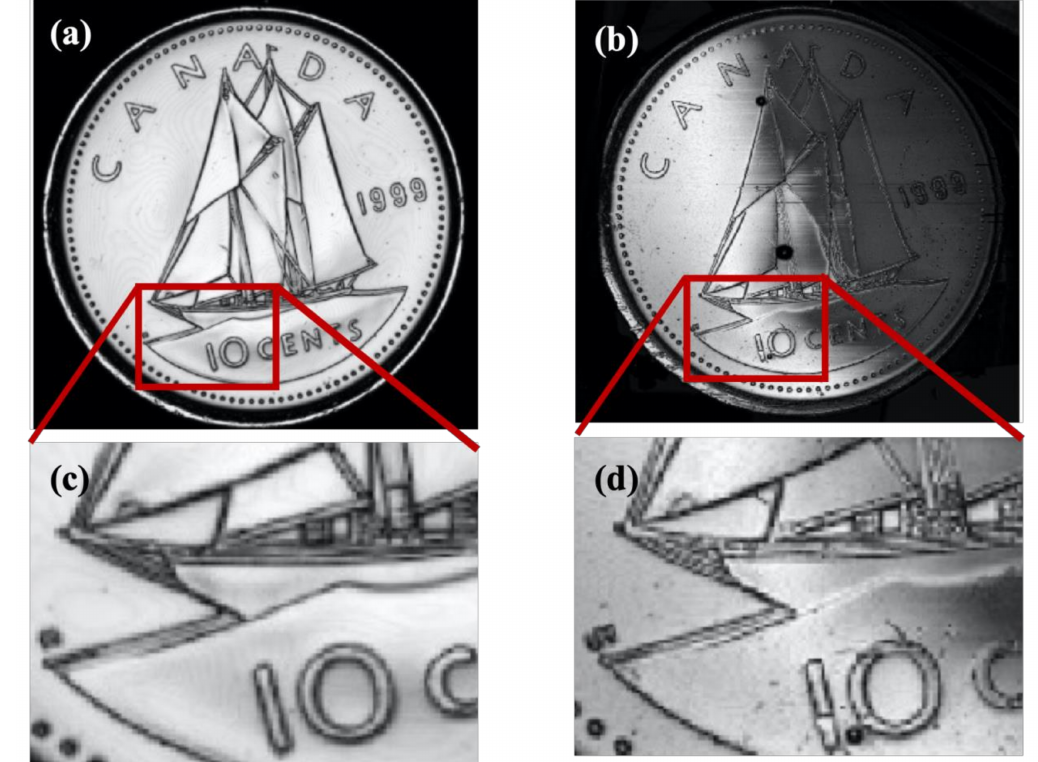
Figure 9. ( a ) C-scan of Canadian 10-cents coin by commercial polymer transducer; ( b ) C-scan of transducer by in-house polymer transducer. Images have a dimension of 20 × 20 mm 2 . ( c , d ) are the magnified views of ( a , b ), respectively.